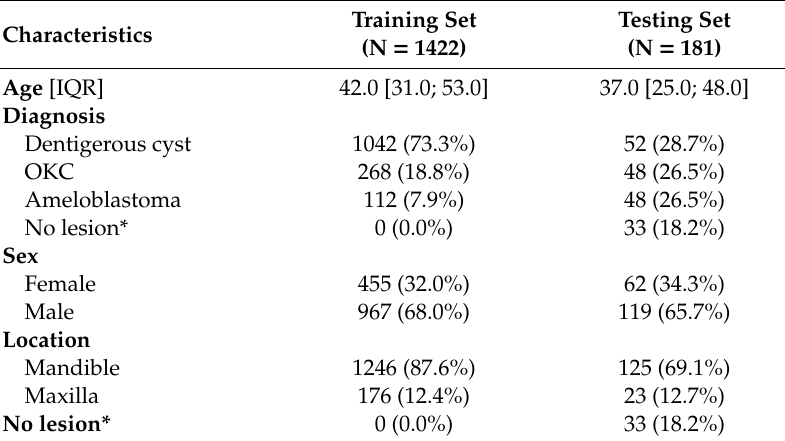
Table 1. Demographic data of the study subjects (N =